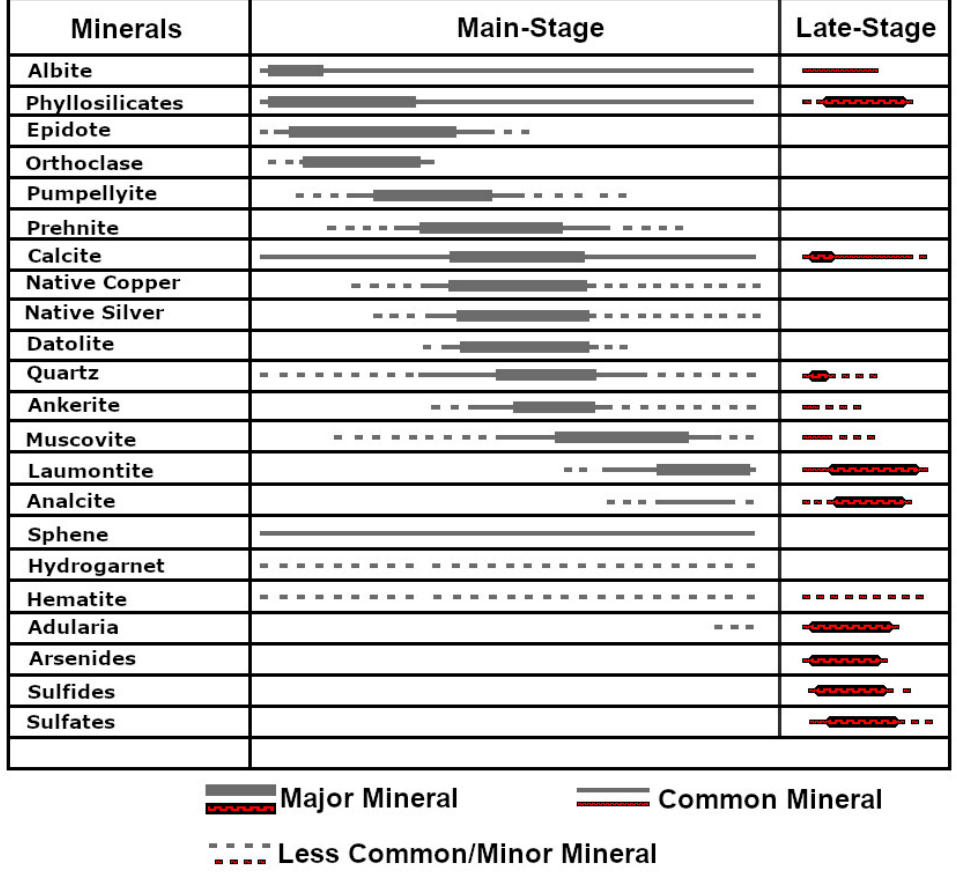
Figure 4. Paragenesis of mineral formation within the Keweenaw Peninsula native copper district. Modified from [4,18].